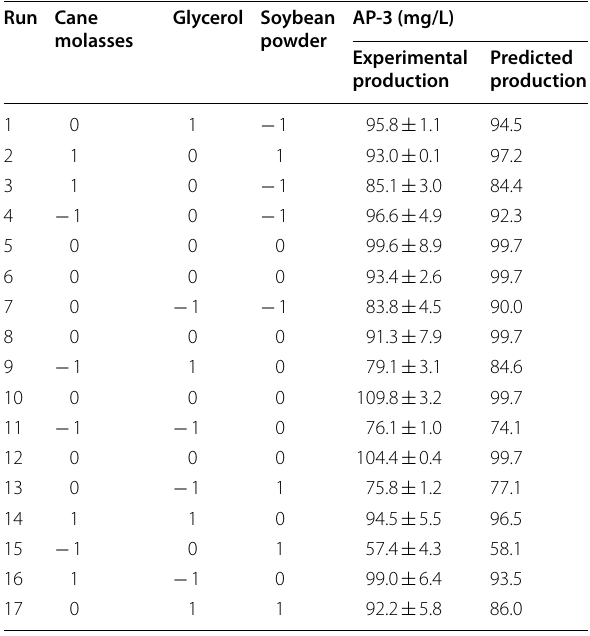
Table 3 Matrix of independent variables in coded and actual values with their corresponding responses Run Cane Glycerol Soybean AP‑3 (mg/L) molasses powder Experimental